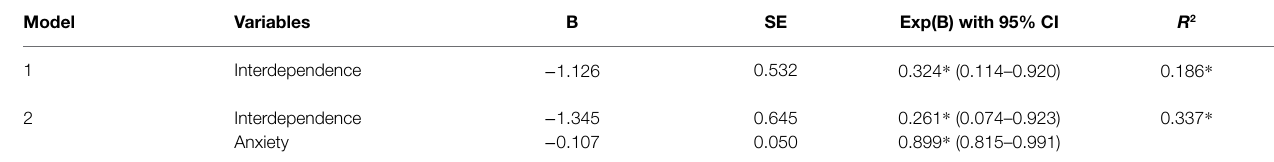
TABLE 1 | Hierarchical logistic regression of metacognitive efficiency levels with interdependence and self-reported anxiety as predictors. N = 30. Model